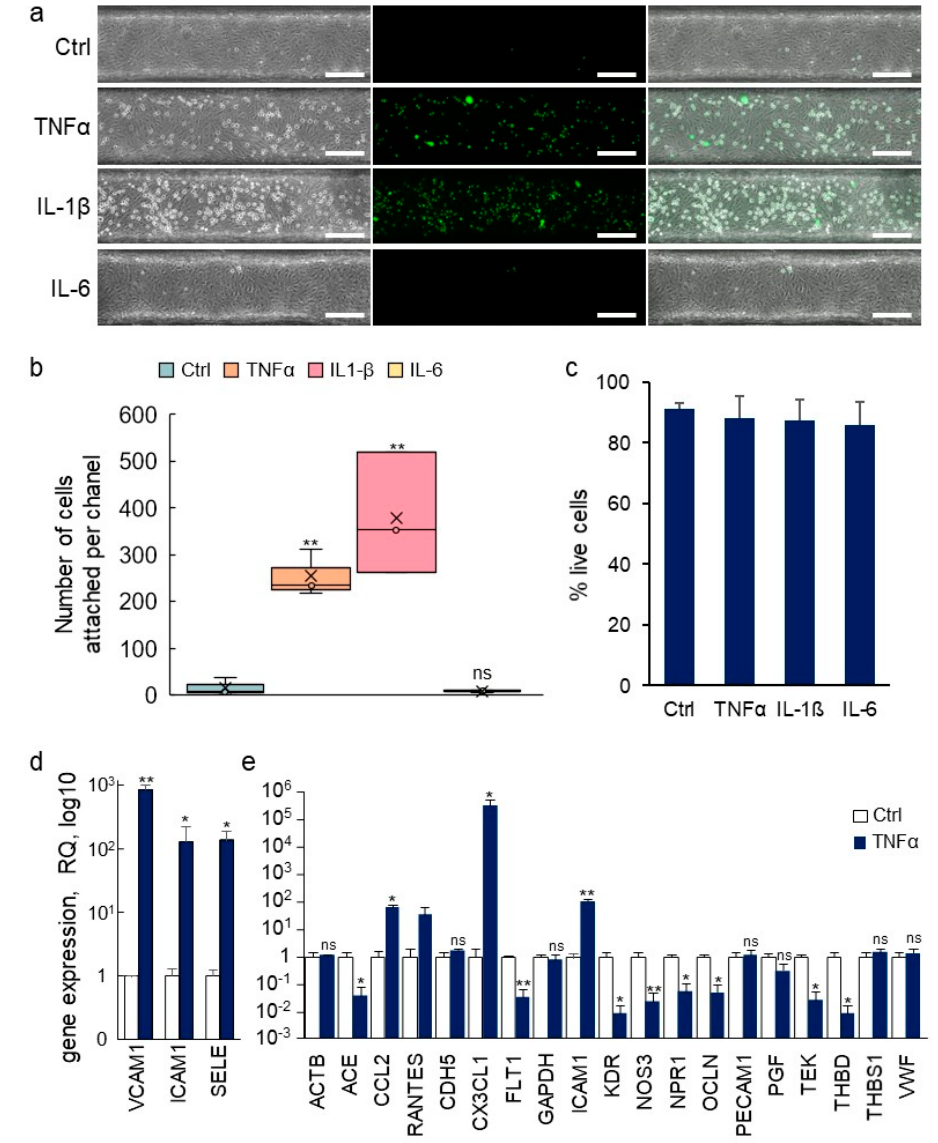
Figure 9. Immune activation of VoC. ( a ) VoC were stimulated or not with TNF α (0.57 nM), IL-1 β (0.59 nM), or IL-6 (0.48 nM) for 4 h, then, calcein AM-labeled THP-1 monocytes (green) were injected in the lumens and allowed to adhere onto the luminal face of the endothelium. Left—phase contrast; middle—fluorescent imaging; right—merged images, bar= 200 µm. ( b ) Quantification of the numbers of immune cells attached to the vessel walls along the entire channels, n = 3. ( c ) Percentage of living endothelial cells after treatments with cytokines as in ( a ). ( d ) RT-qPCR array analysis of gene expression in endothelial cells recovered from VoC following stimulation or not with TNF α (0.57 nM) for 4 h. ( e ) Taqman array card analysis of expression of genes following extraction of single vessels-on-chips, a selection of genes is presented, n = 4, * p < 0.05, ** p < 0.01; ns—nonsignificant, compared to